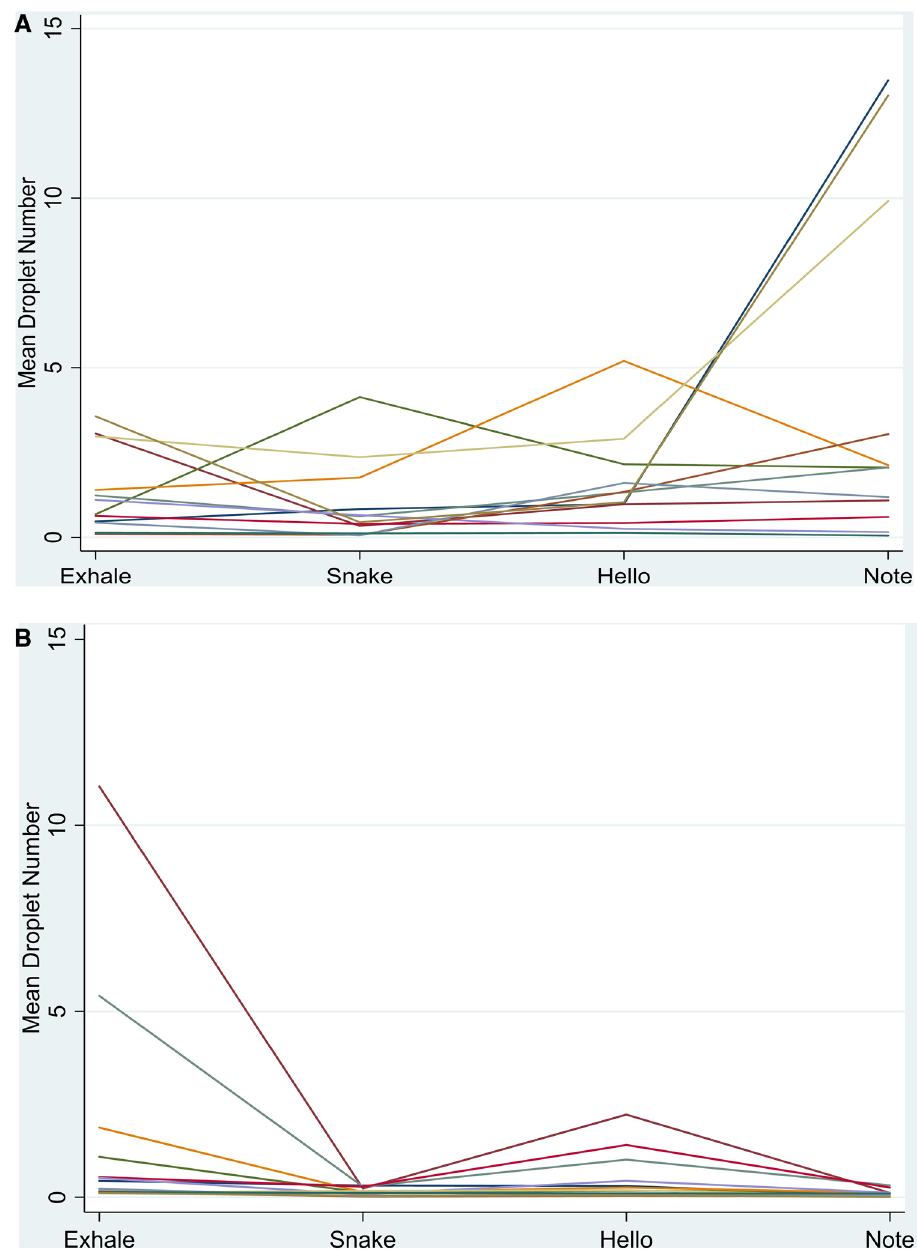
Figure 5. The mean droplet density for each task is plotted showing the differences between individuals. ( A ) Variation in droplet transmission when not wearing a mask. Each line represents an individual participant. ( B ) Variation in droplet transmission when wearing a